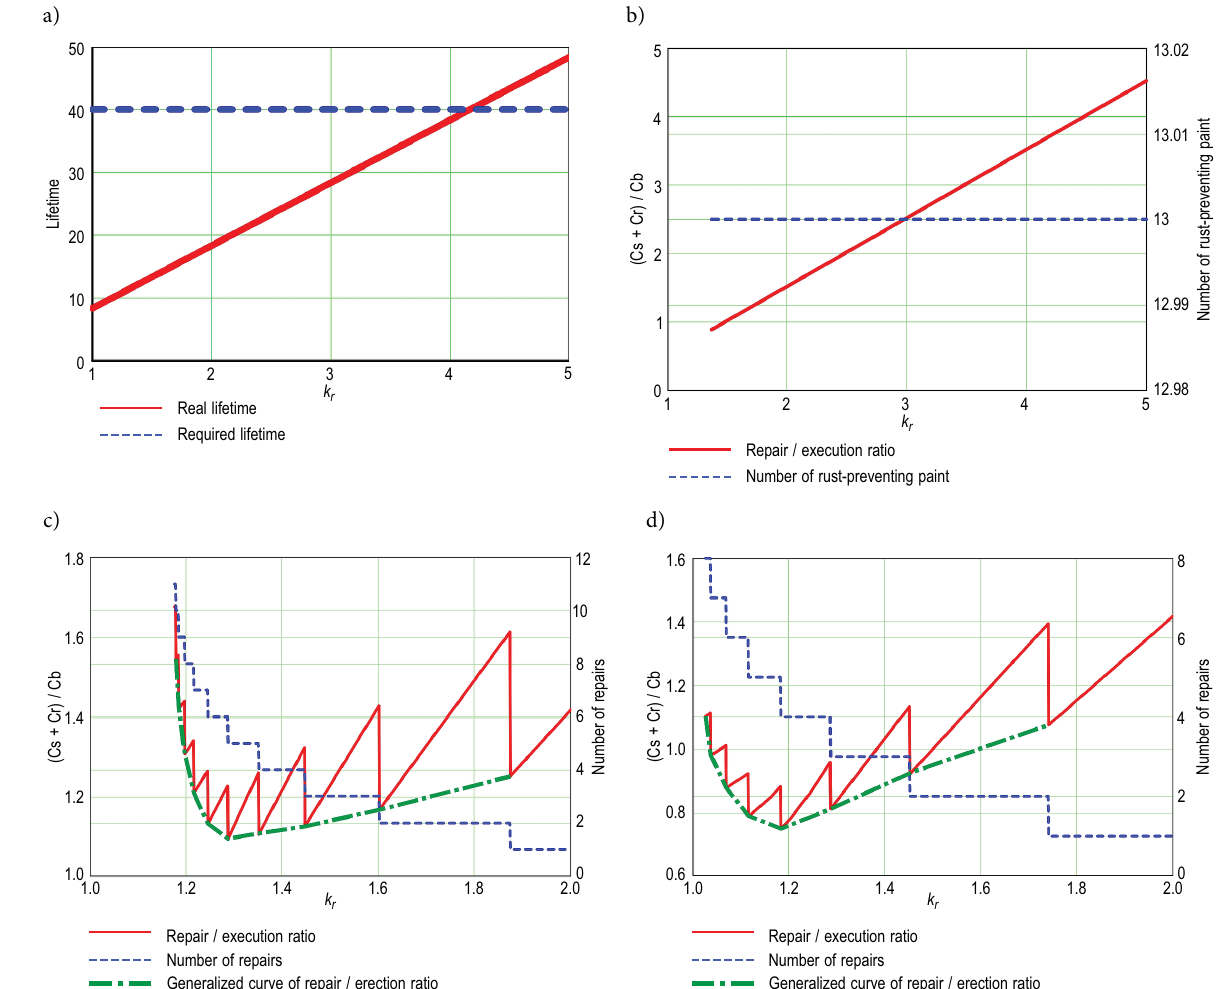
ratioNumber of Generalized curve of repair / erection